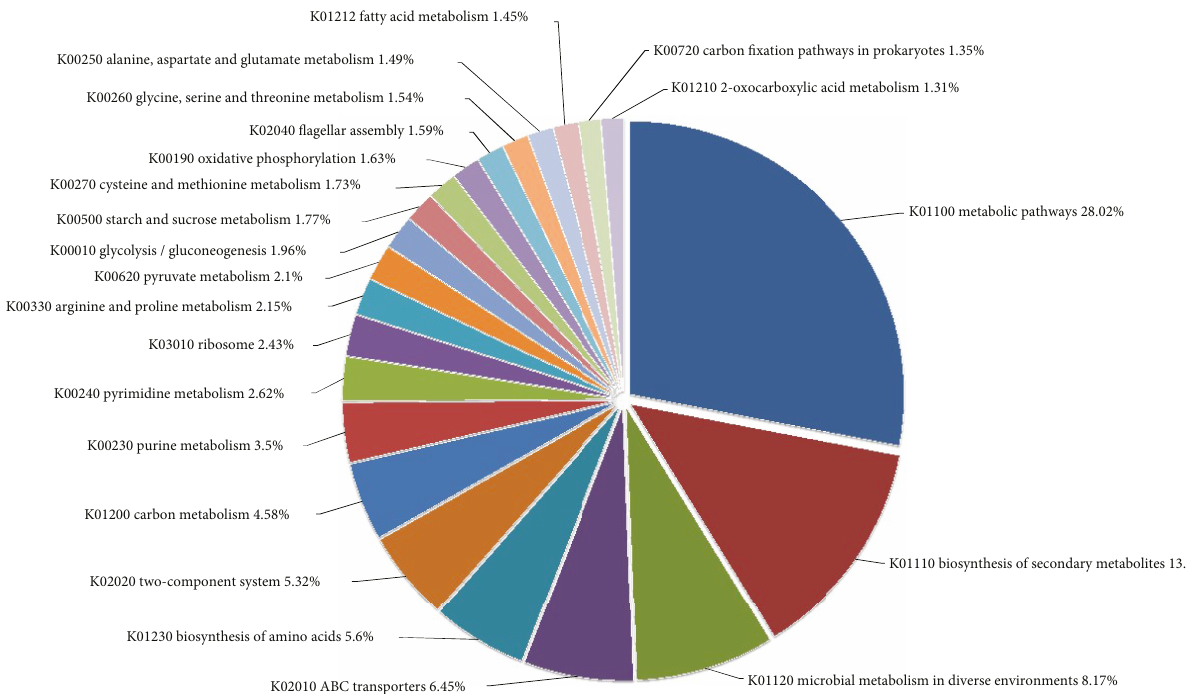
Figure 7: Top KEGG pathways enriched in strain DM2 genome and the percentage of genes under each